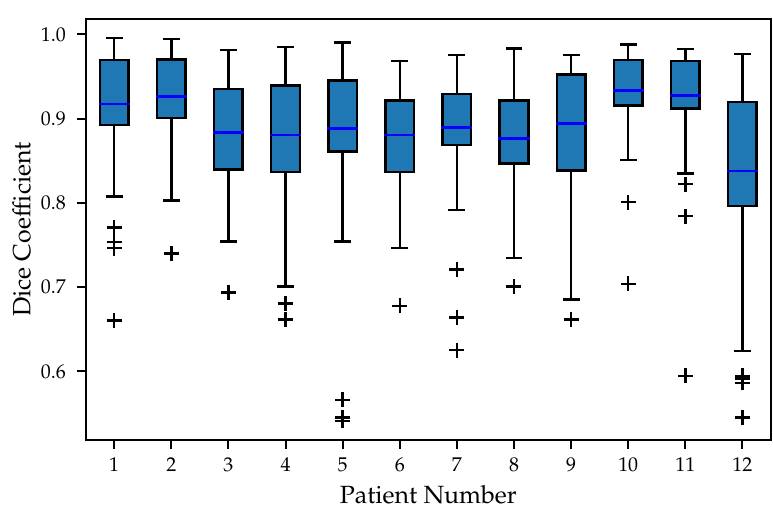
Figure 8. The evaluation results of the 2D segmentation result using the Smart